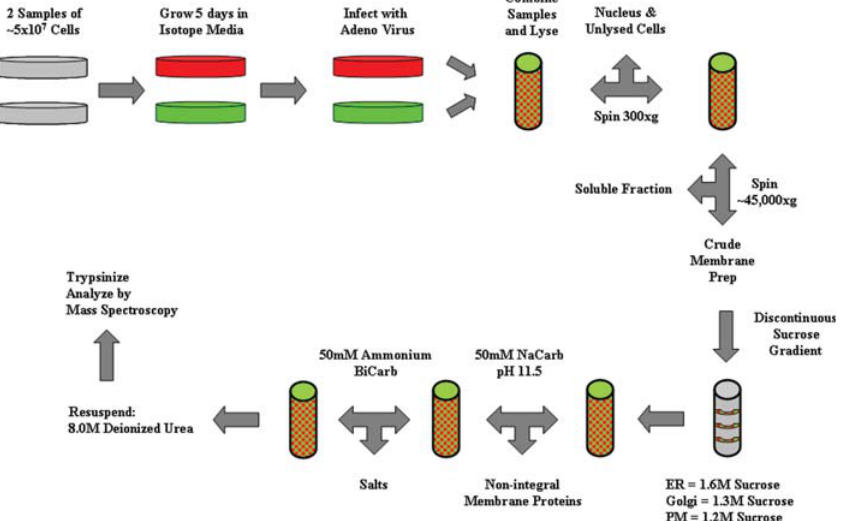
Figure 1. Schematic Representation of the SILAC Labeling and Purification Protocol HeLa cells were grown for 5 d in labeling medium to ensure complete labeling. They were then infected with either adenovirus vector (light sample) or adenovirus-expressing K5 (heavy sample). Then 24 h post-infection, cells were harvested and counted, and equal numbers of cells combined. Samples were lysed in a Dounce homogenizer and unlysed cells removed by centrifugation. Membrane and soluble proteins were separated by centrifugation. The membrane pellet was resuspended, and different membrane fractions were separated over a discontinuous sucrose gradient. The bands corresponding to the plasma membrane (PM), Golgi, and ER fractions were removed and the proteins pelleted. The resulting pellet was then washed with sodium carbonate to remove non-integral membrane proteins, followed by ammonium bicarbonate to remove salts and other impurities. The final pellet was resuspended in 8 M urea and digested with trypsin for MS/MS analysis. DOI: 10.1371/journal.ppat.0020107.g001